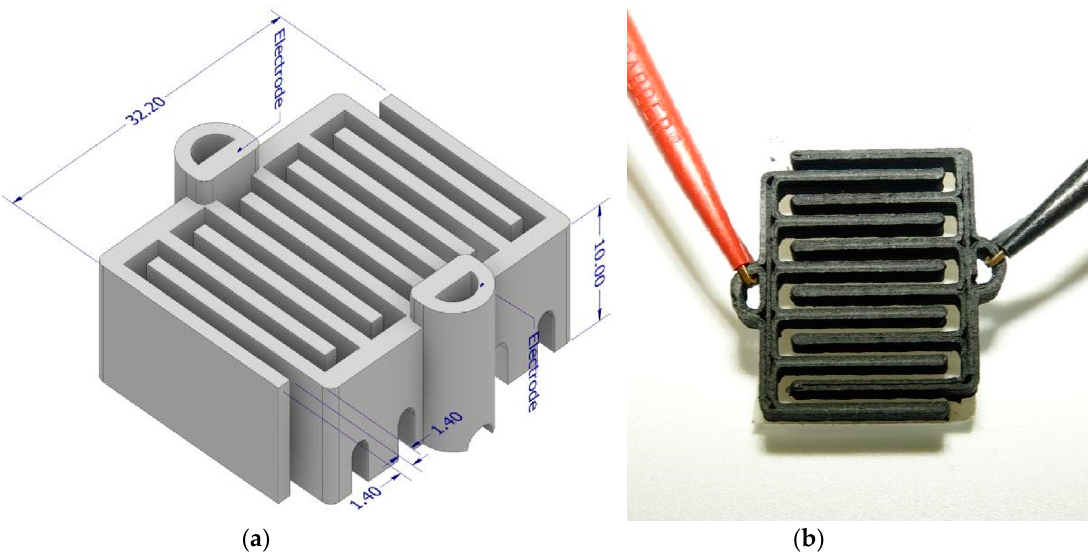
Figure 1. ( a ) CAD drawing of the tested interdigital capacitor with given dimensions in mm. The channels at the bottom were introduced to ensure a uniform fluid distribution between the digits/plates; ( b ) Photo of the tested sensor with connected